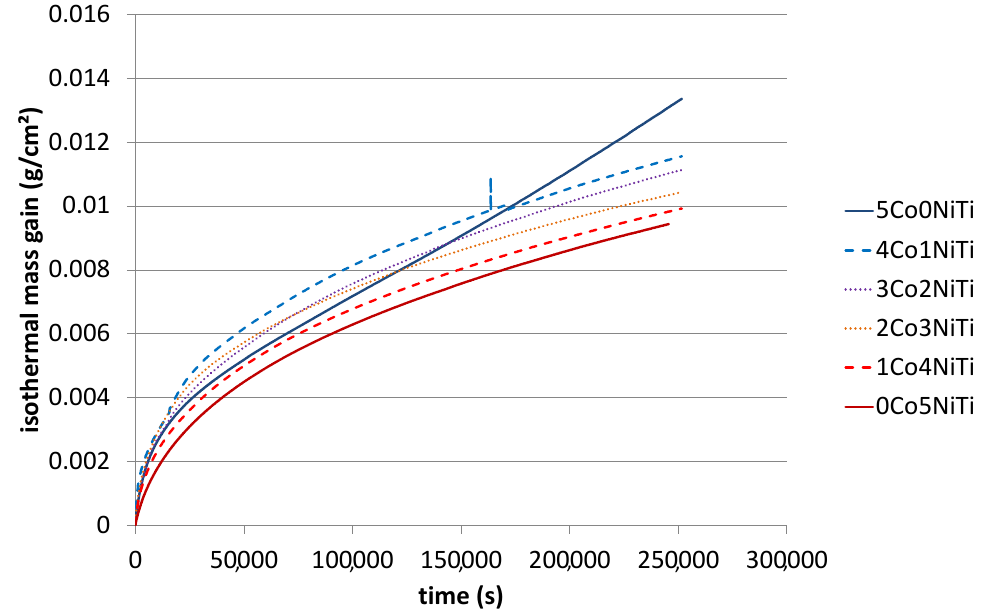
Figure 2. The mass variation curves plotted versus time to observe the mass gain evolution for all the six alloys during the isothermal stage. Table 3. Values of the kinetic constants determined for the isothermal oxidation using the classical method (5Co0NiTi) or the complete method taking chromia volatilization into account (the five other